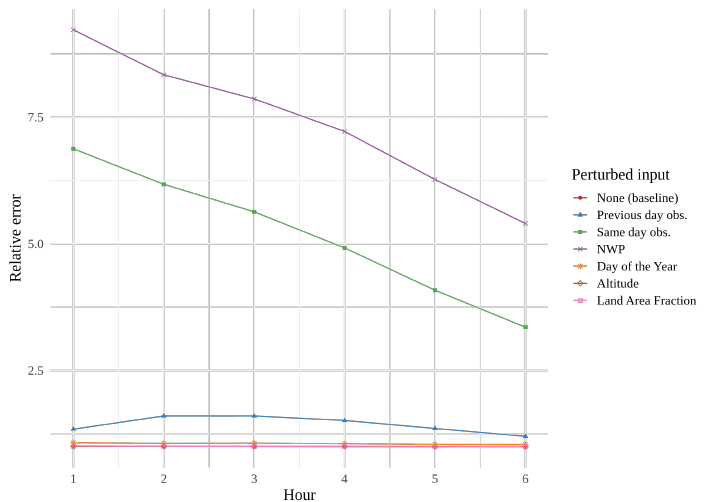
Figure 15. Permutation feature importance of the best convLSTM, i.e., the error resulting from the permutation of one parameter, leaving the remaining parameters untouched.